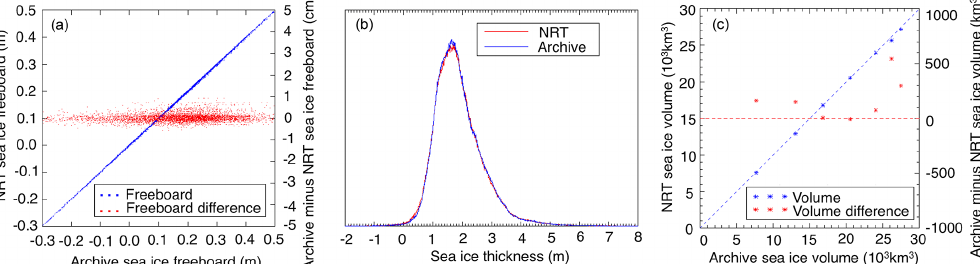
Figure 2. Comparison of near-real-time (NRT) and archive estimates of Arctic sea ice freeboard, thickness and volume, from CryoSat-2. (a) Cross-plot of point-by-point sea ice freeboard for an Arctic pass in April 2015. Also shown is the difference (archive minus NRT) in sea ice freeboard between the data sets. (b) Normalized distribution of NRT and archive thickness estimates over the period October 2014-April 2015 for all grid cells where measurements are available for both data sets. (c) Cross-plot of sea ice volume for October 2014-April 2015. Also shown is the difference (archive minus NRT) in sea ice volume between the data